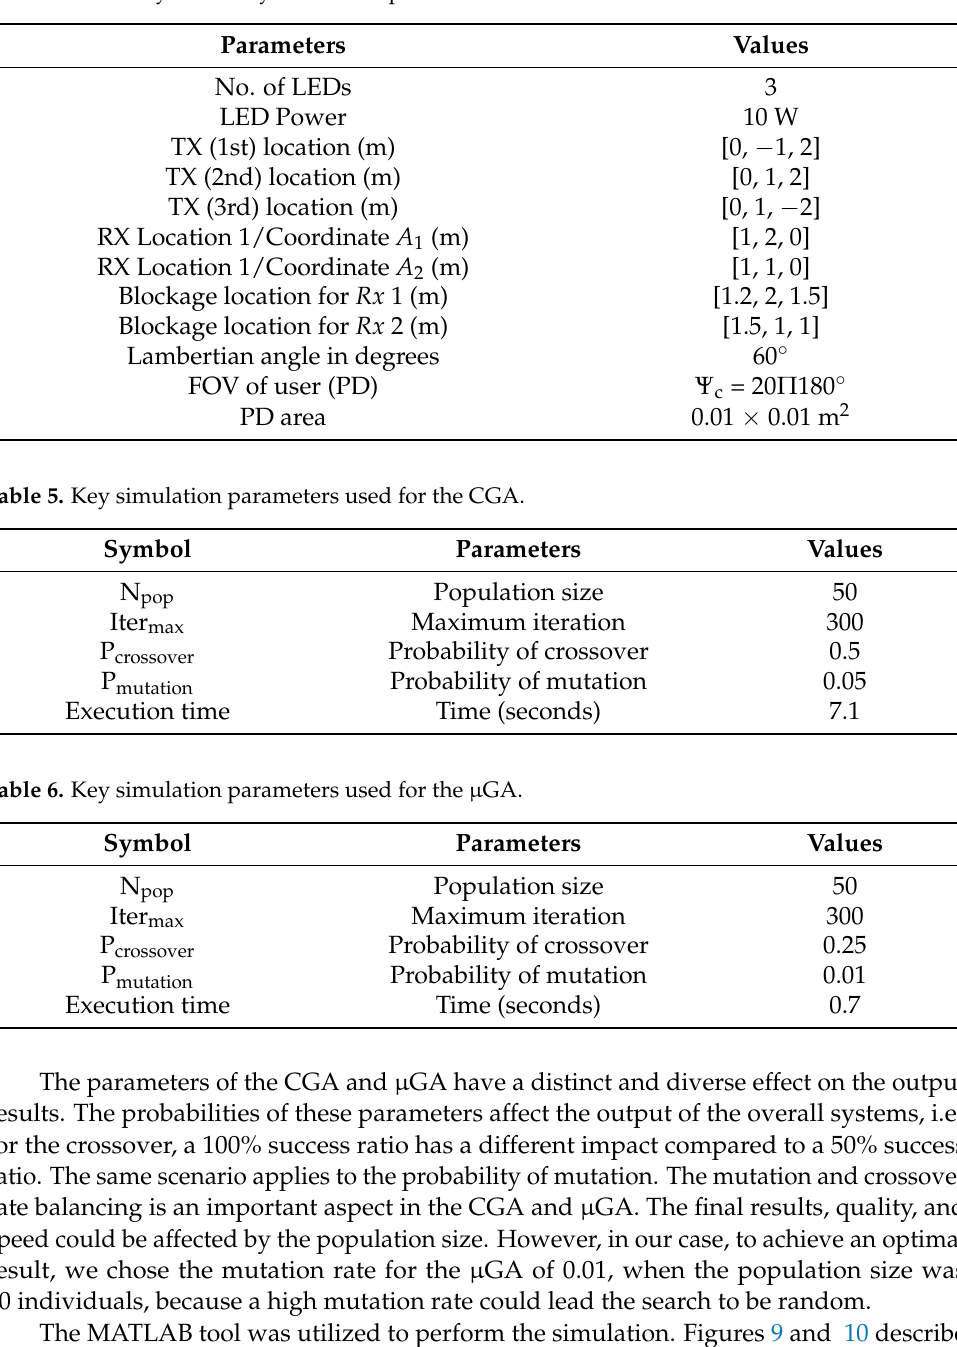
Table 4. Summary of the key simulation parameters of the NLOS environment.